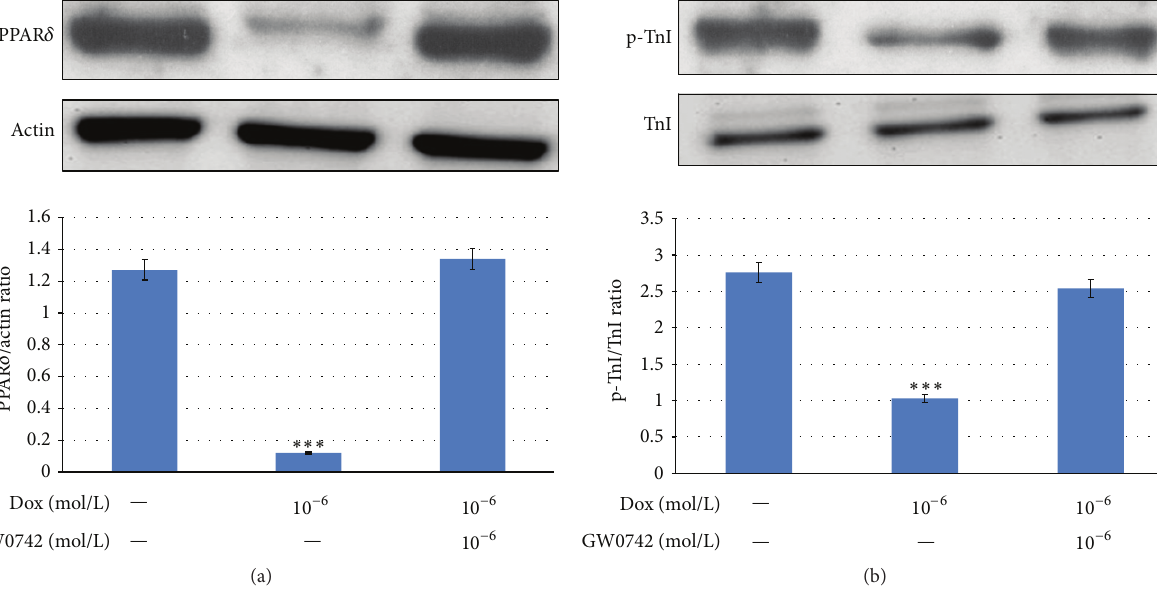
Figure 4: Effects of GW0742 on PPAR 𝛿 expression and cardiac troponin I phosphorylation in doxorubicin-treated neonatal rat cardiomyocytes. Changes of PPAR 𝛿 expression (a) and cardiac troponin I phosphorylation (b) in DOX-treated cells by GW0742. Cells were treated with 10 −6 mol/L GW0742 for 1 hour before the incubation with 10 −6 mol/L DOX. After 24 h, they were harvested for measuring PPAR